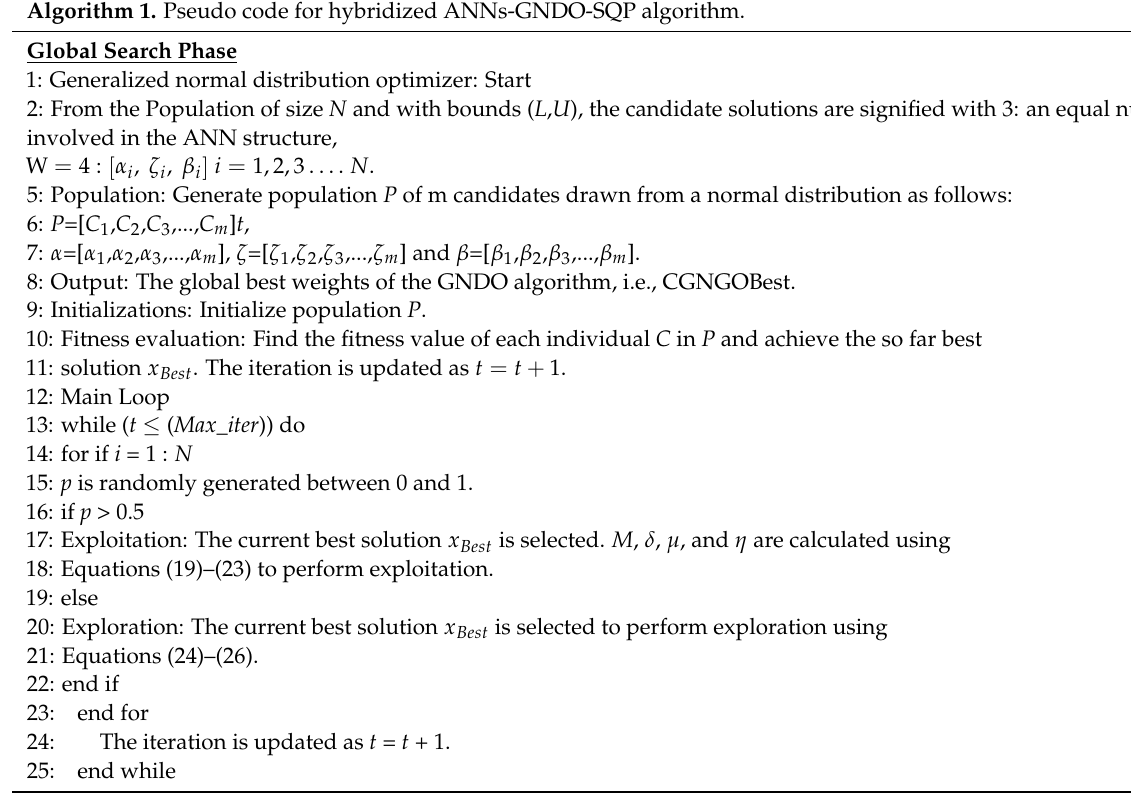
Algorithm 1. Pseudo code for hybridized ANNs-GNDO-SQP algorithm. Global Search